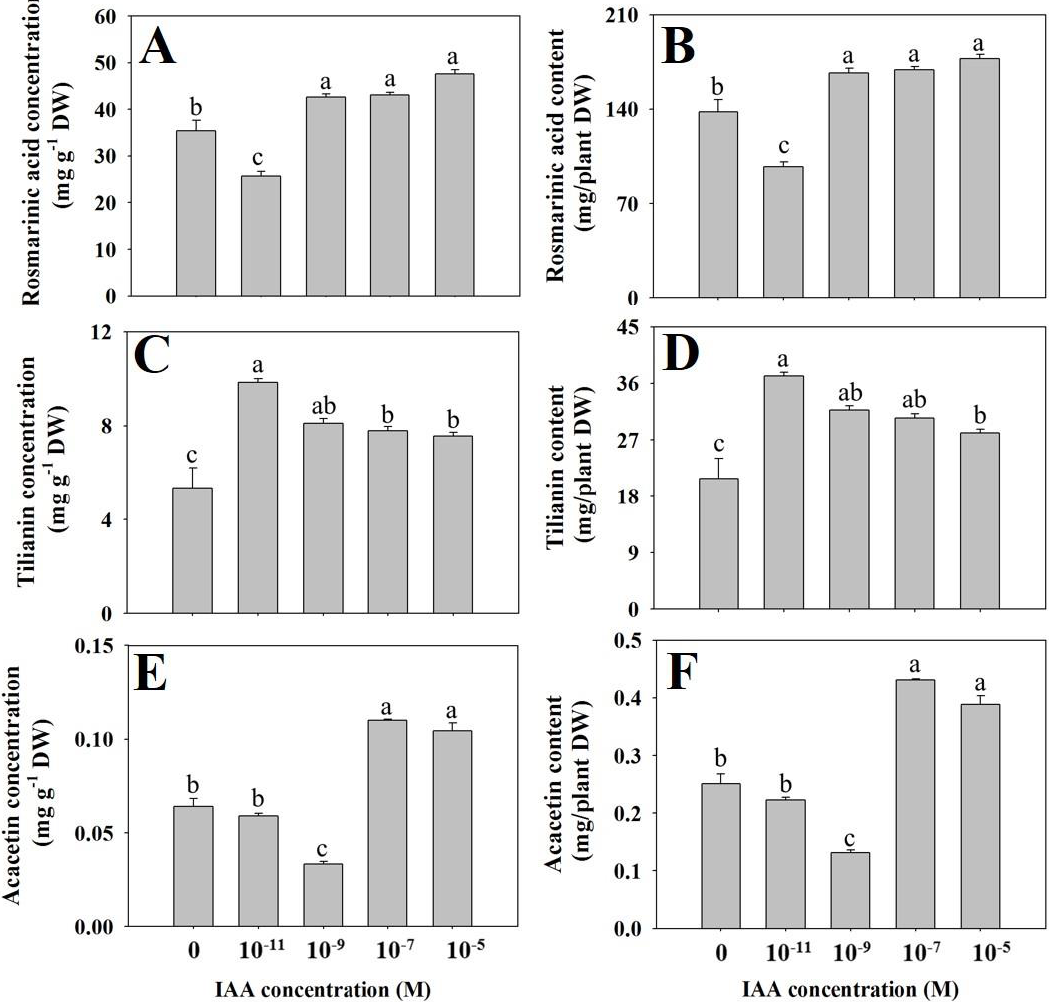
Figure 4. Rosmarinic acid ( A , B ), tilianin ( C , D ), and acacetin ( E , F ) concentrations and contents in the whole plant of A. rugosa subjected to the control (without IAA) and four IAA treatments. Different letters (a–c) indicate significant differences among treatments at p ≤ 0.05 ( n = 3).